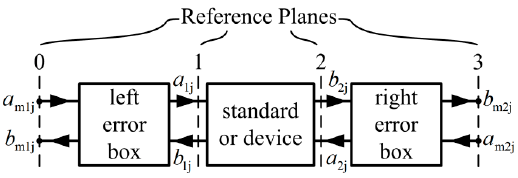
Figure 1. Error model of a two-port vector network analyzer (VNA).